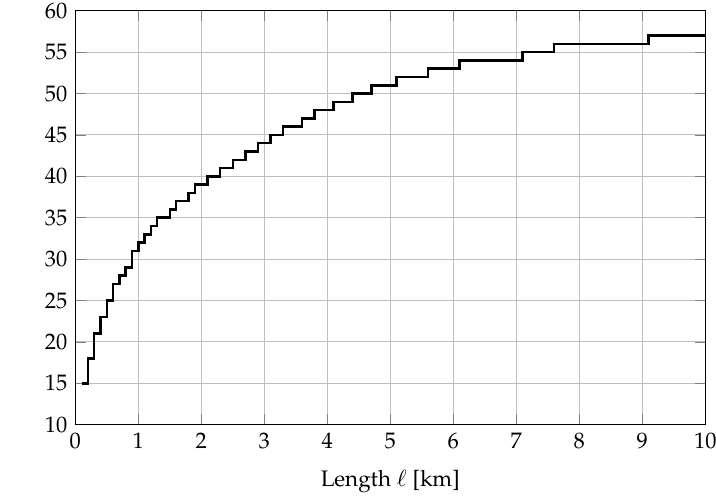
Figure 12. The upper limit of PI-sections for different cable